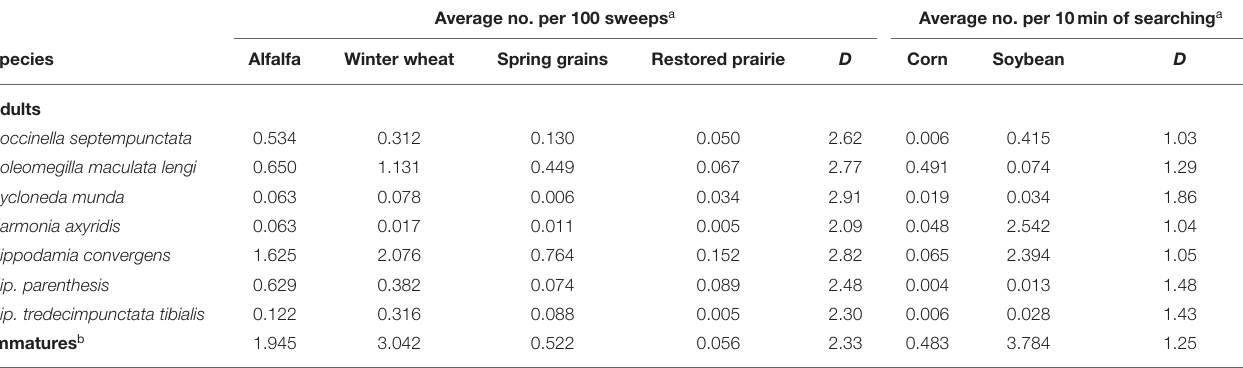
TABLE 4 | Abundance of predacious coccinellids and evenness ( D ) in their habitat use among selected field crops and restored prairie in east-central South Dakota, 2007–2020. Average no. per 100 sweeps a Average no. per 10min of searching a Alfalfa Winter wheat Spring grains Restored prairie Corn